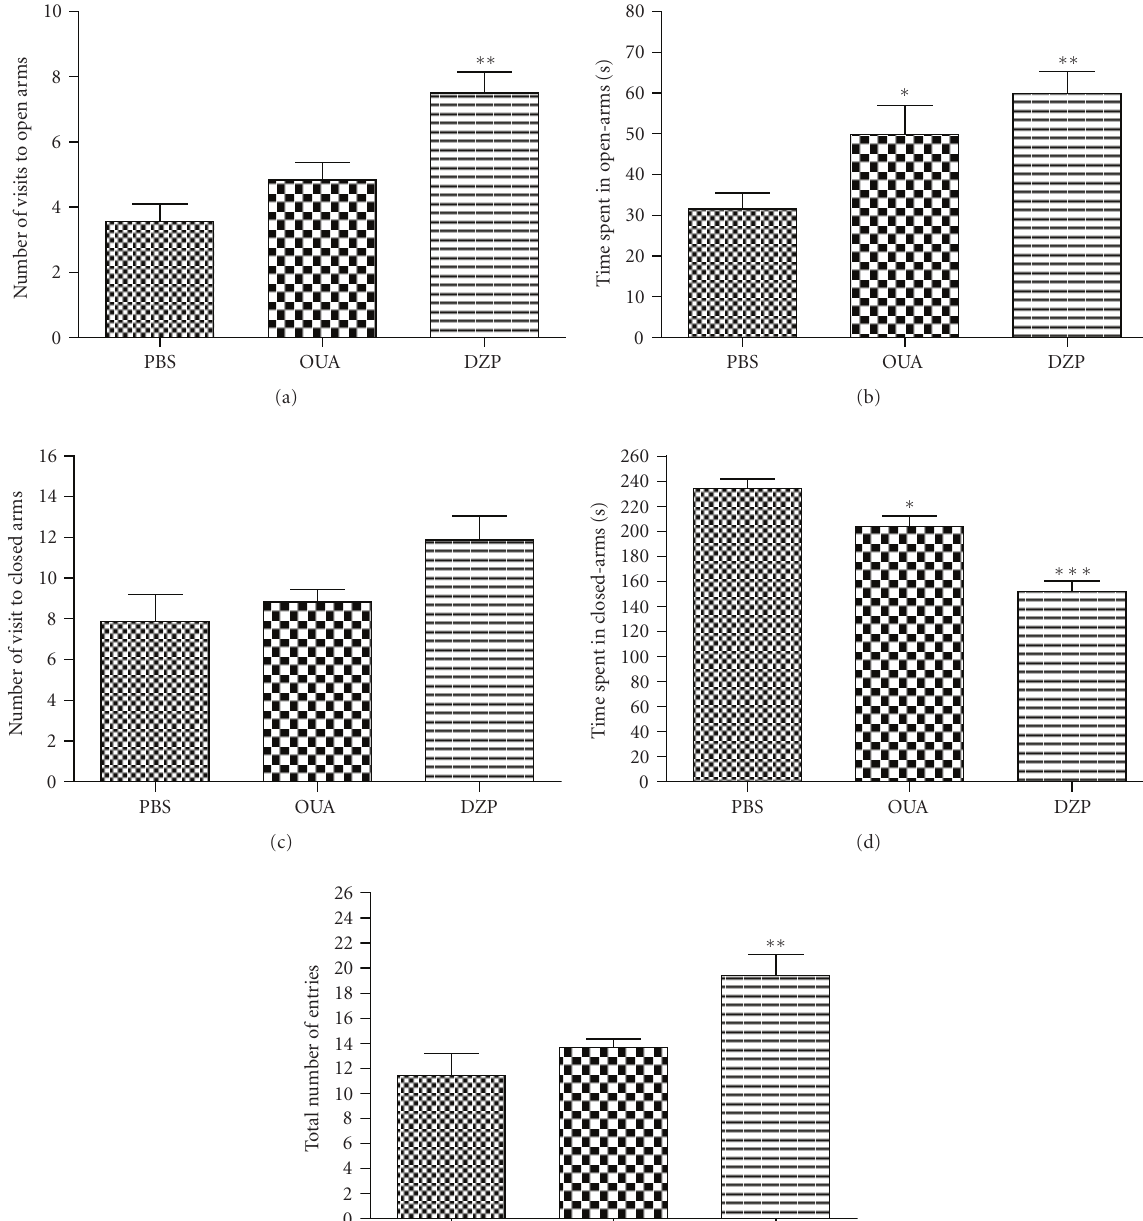
Figure 6: E ff ect of the pretreatment with Ouabain (OUA 0.56mg/kg) administered intraperitoneally on elevated plus-maze test in mice. (a) Number of visit to open-arms; (b) Time spent in open-arms; (c) Number of visit to closed-arms; (d) Time spent in closed arms; (e) Total numbers entries. Each bar represents the mean of seven or eight animals. Diazepan (DZP 0.5mg/Kg) was used as positive control. Data were expressed as mean ± S.E.M. and analyzed by software Graphpad Prism using ANOVA followed Mann Whitney test or Student’s t -test followed by unpaired test: ∗ P < . 05, ∗∗ P < . 01, and ∗∗∗ P < .